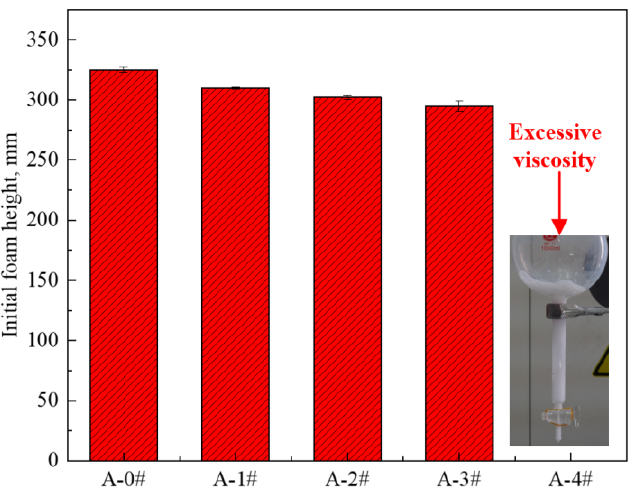
Figure 2. Initial foam height of five foam dispersions.